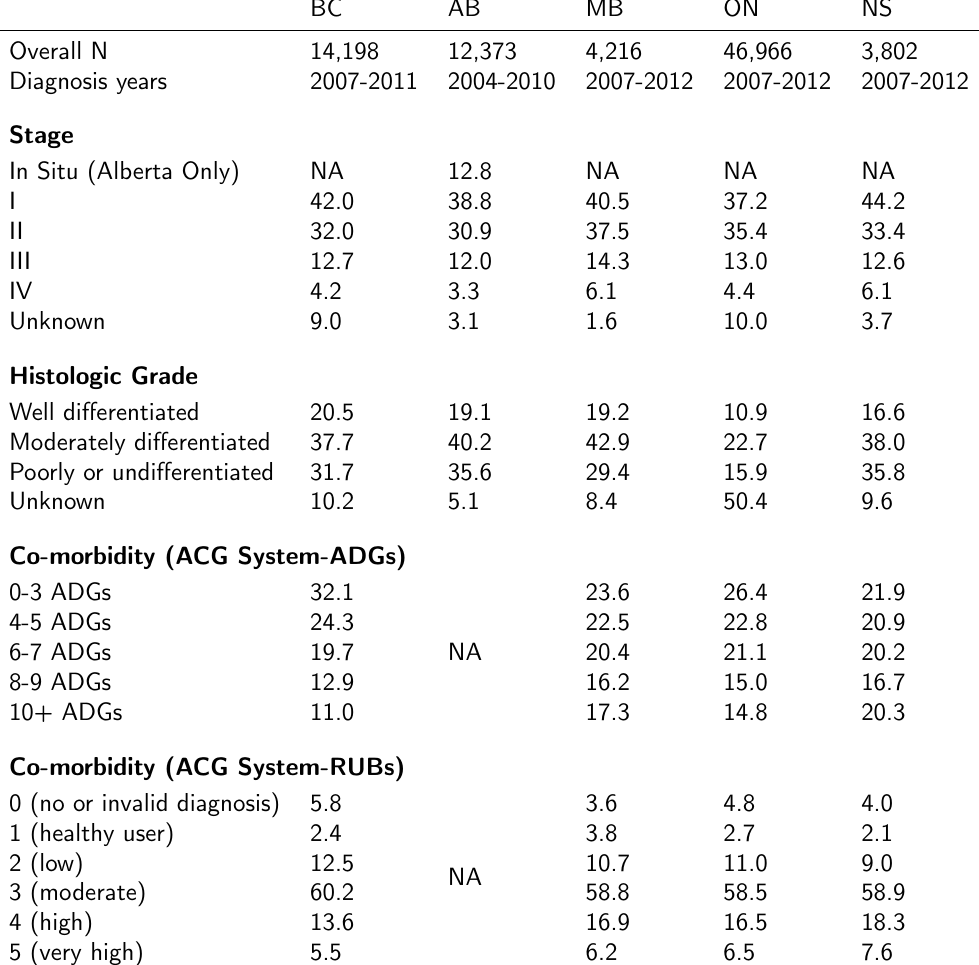
Table 2: Demographic characteristics of the CanIMPACT provincial breast cancer cohorts